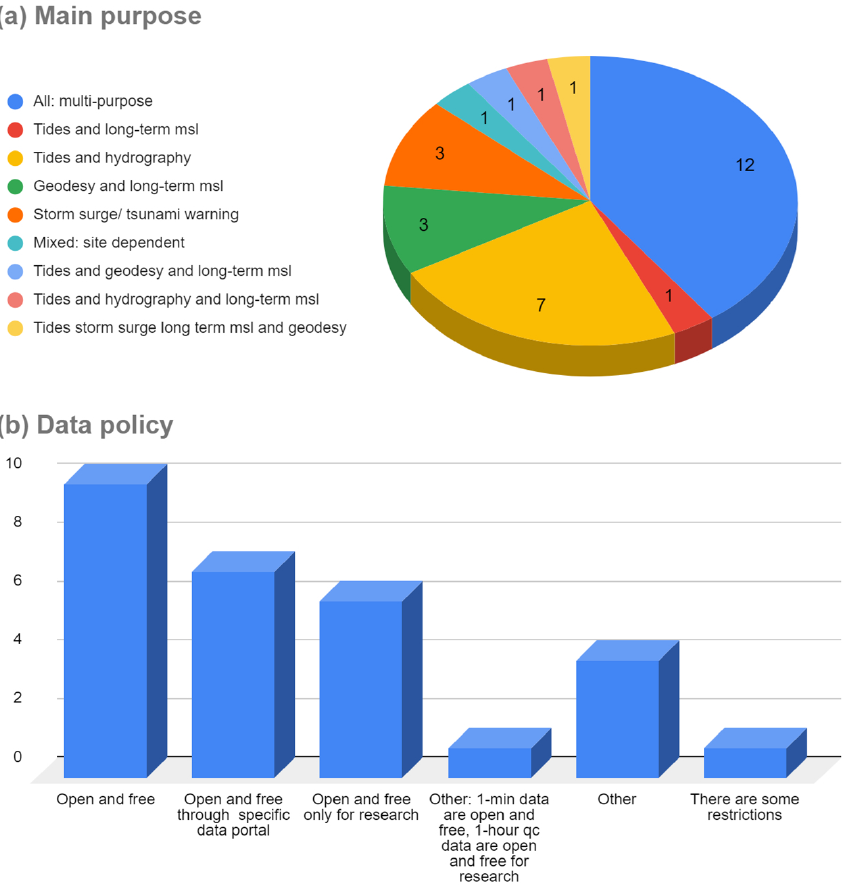
Figure 2. (a) Primary objective of the coastal sea level monitoring networks based on responses to the survey and (b) data policy of the operating institutions as collected by the